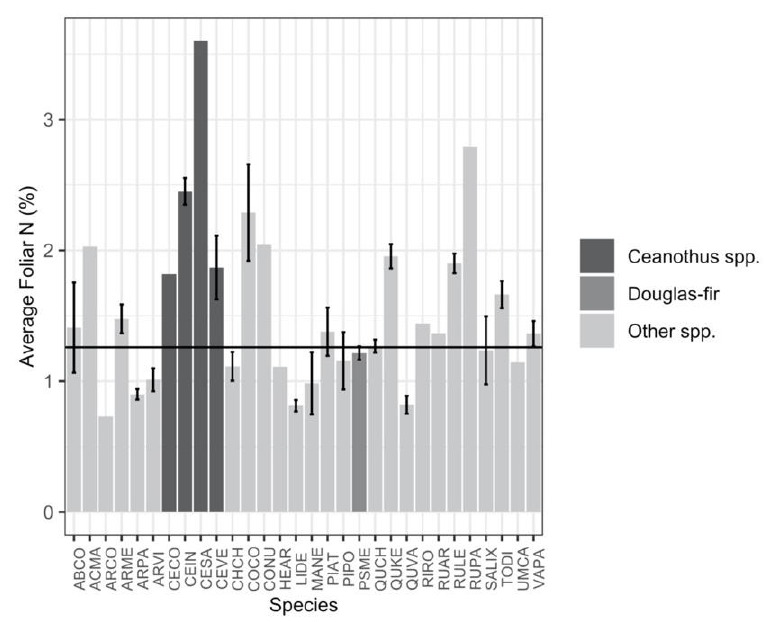
Figure 5. Plot-level average foliar nitrogen concentrations (%) for all species, with Ceanothus spp. and Douglas-fir marked with different colors. The black line shows the average of all species other than Ceanothus spp. Error bars represent standard errors of the means. Species that do not have error bars indicate sampling from a single plot ( n = 1). Species abbreviations and corresponding Latin names used on the x -axis can be found in Table S1.